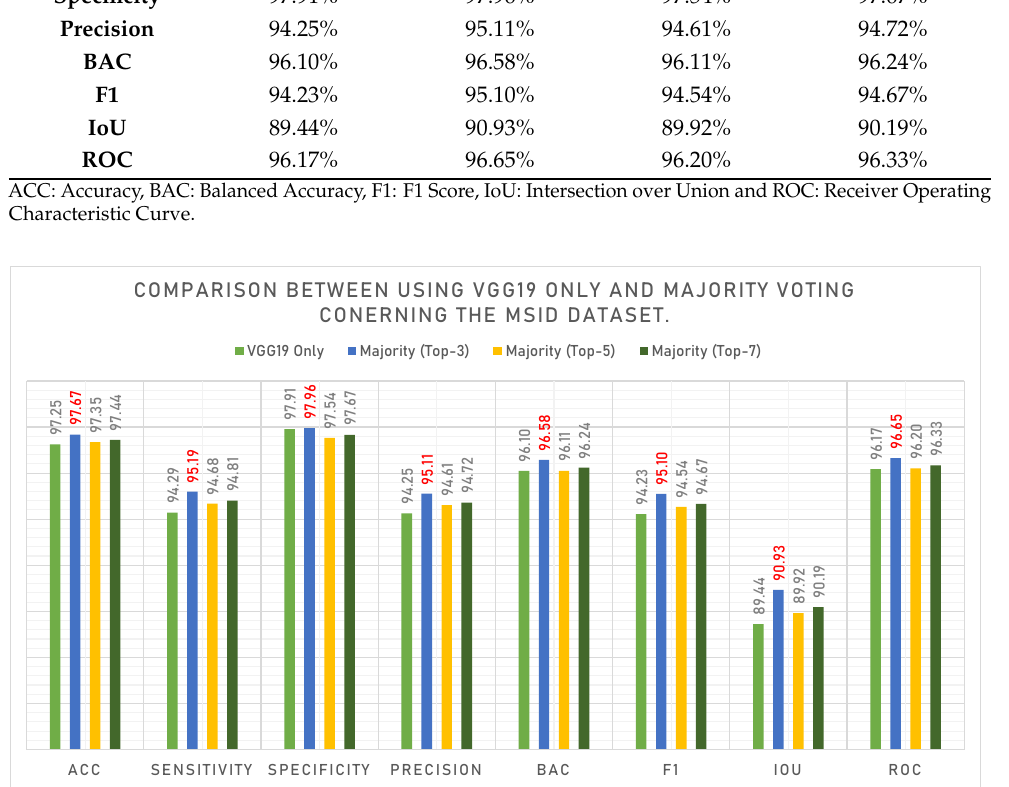
Figure 4. Graphical comparison between the results presented in Table